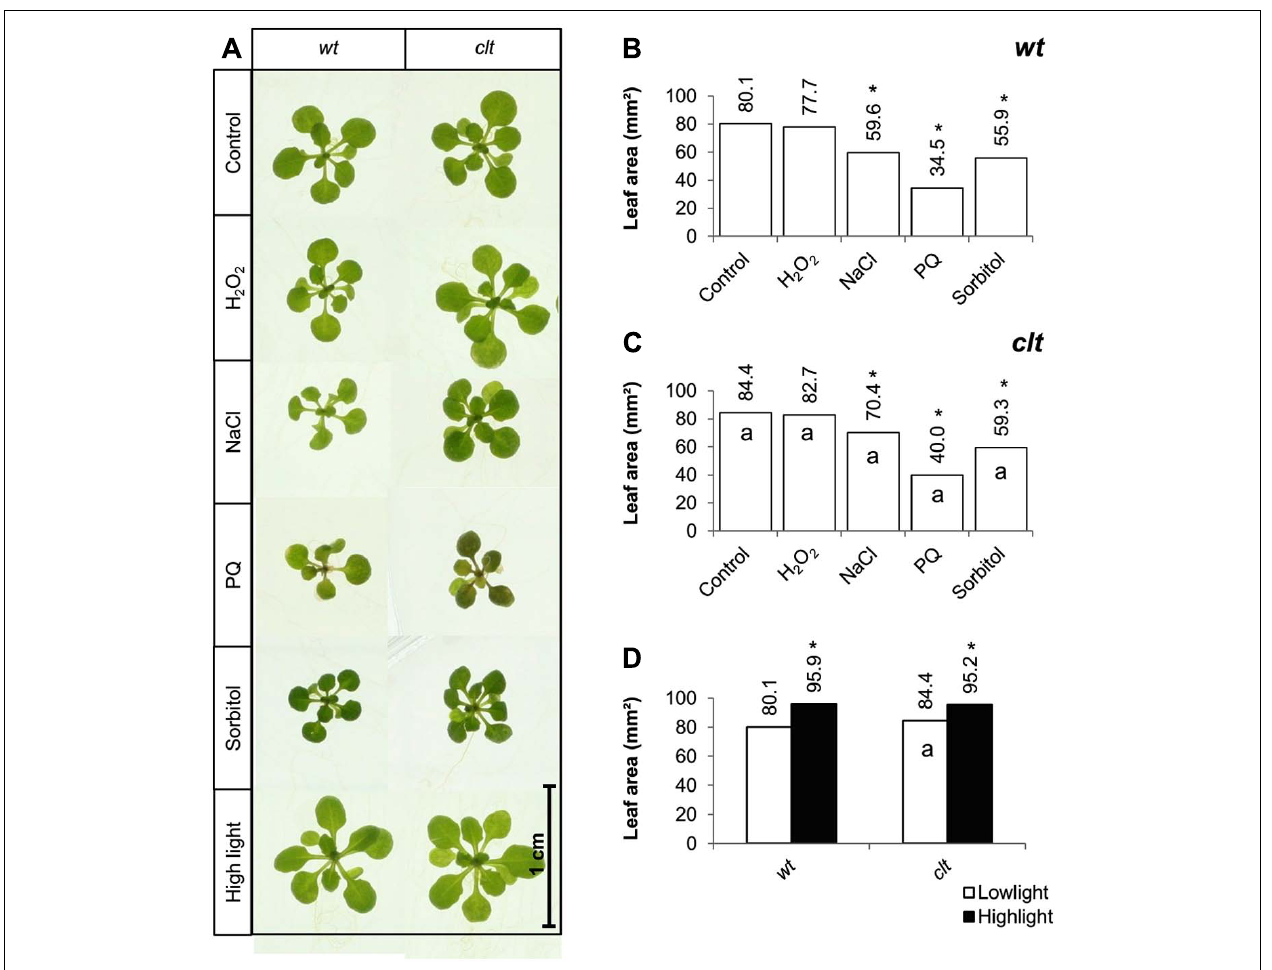
FIGURE 6 |A comparison of the effects of short-term (4 days) exposures to different abiotic stresses treatments on rosette leaf area in the clt1clt2clt3 triple mutants relative to wild type, Col-0 (wt). In ( A–C) seedlings were grown for 10 days under optimal conditions and then transferred different abiotic stress treatments for a further 4 days. Phenotypes (A) and leaf area (B,C) of seedlings measured at 14 days either in the absence (control) or presence of the oxidative stress caused by the